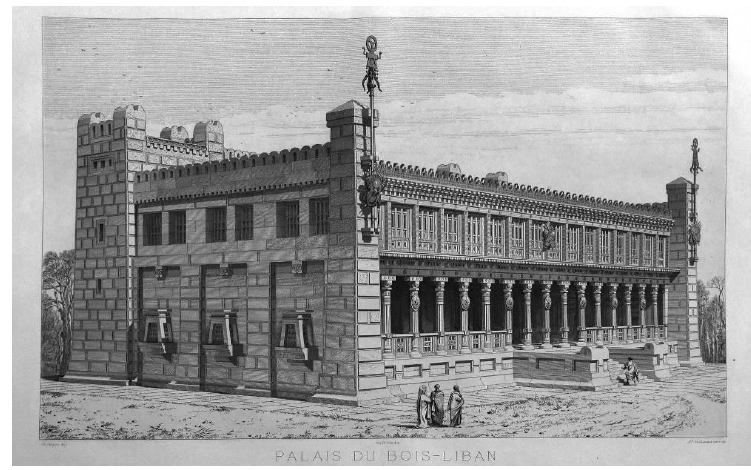
Figure 4. House of the Forest of Lebanon (Chipiez and Perrot 1889, plate 12).